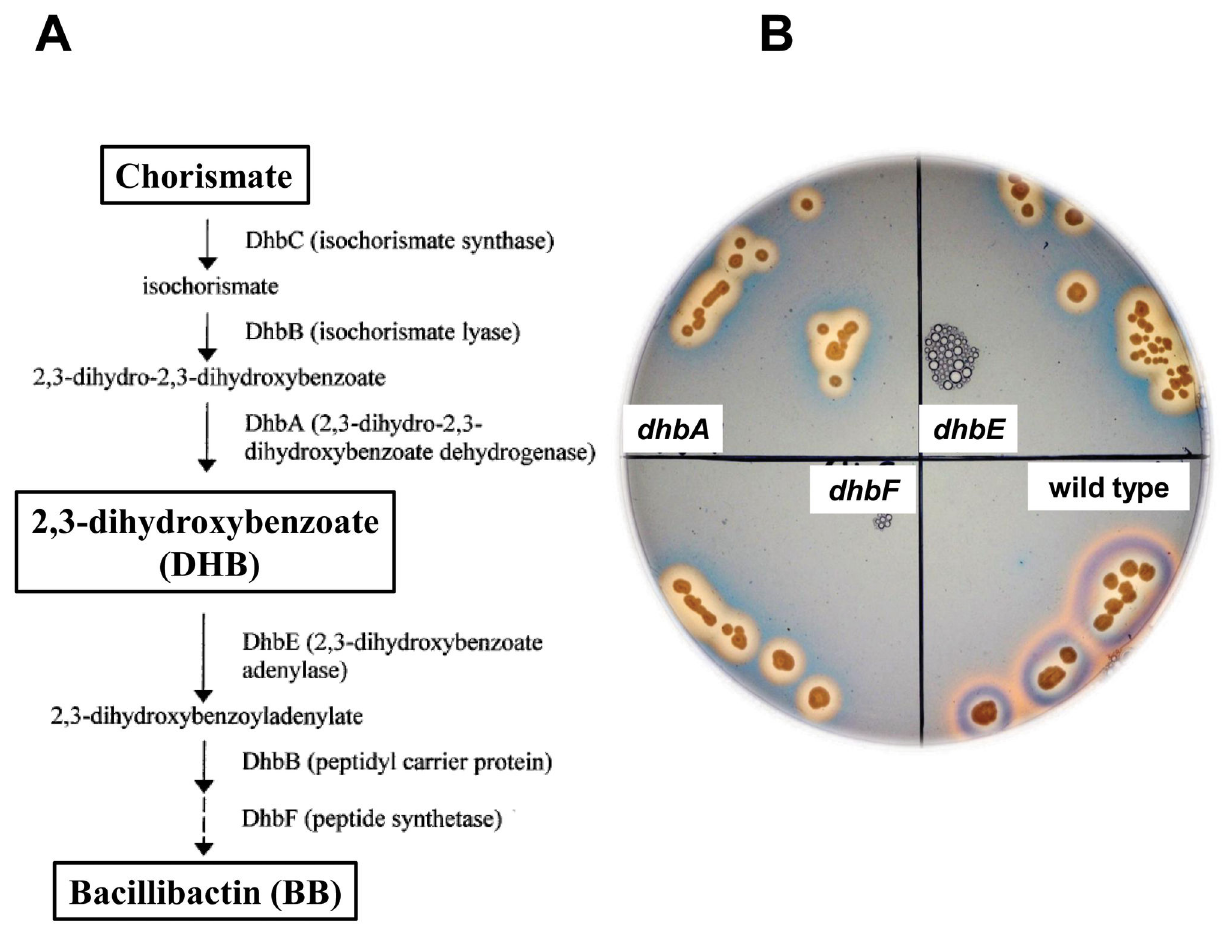
Figure 5. Mutants in dhb genes are defective in bacillibactin (BB) synthesis. A . Production of BB starts with chorismate